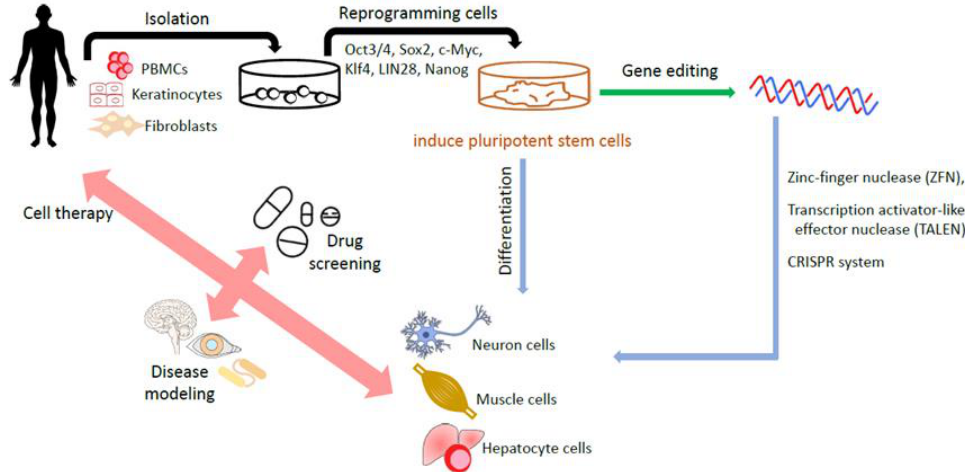
Figure 2. Generation of human iPSCs and their applications. The somatic cells including fibroblasts and isolated from a patient are reprogrammed into iPSCs by transduction with the reprogramming factors. The gene editing technology helps to create iPSCs-based disease cell model. Eventually, iPSCs, with or without edited modifications, are differentiated into various target cells for disease modeling, drug screening, and cell therapy.